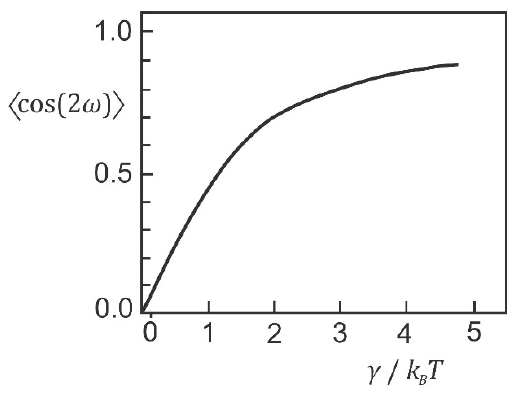
Figure A1. The average orientation 〈cos(2𝜃)〉 of membrane inclusion as a function of 𝛾/𝑘 (cid:3003) 𝑇 . Figure A1. The average orientation (cid:104) cos ( 2 θ ) (cid:105) of membrane inclusion as a function of γ / k It can be seen in Figure A1 that the orientational ordering increases with increasing γ